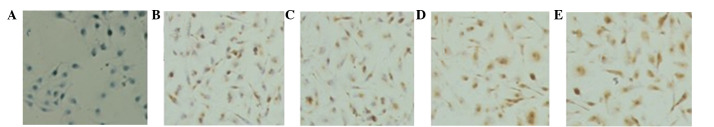
B7-H4 protein expression in 786-0 cells. (A) Negative control; (B) unstimulated; (C) stimulated by interleukin-2; (D) stimulated by interferon (IFN)-α; and (E) stimulated by IFN-γ (magnification, ×200).